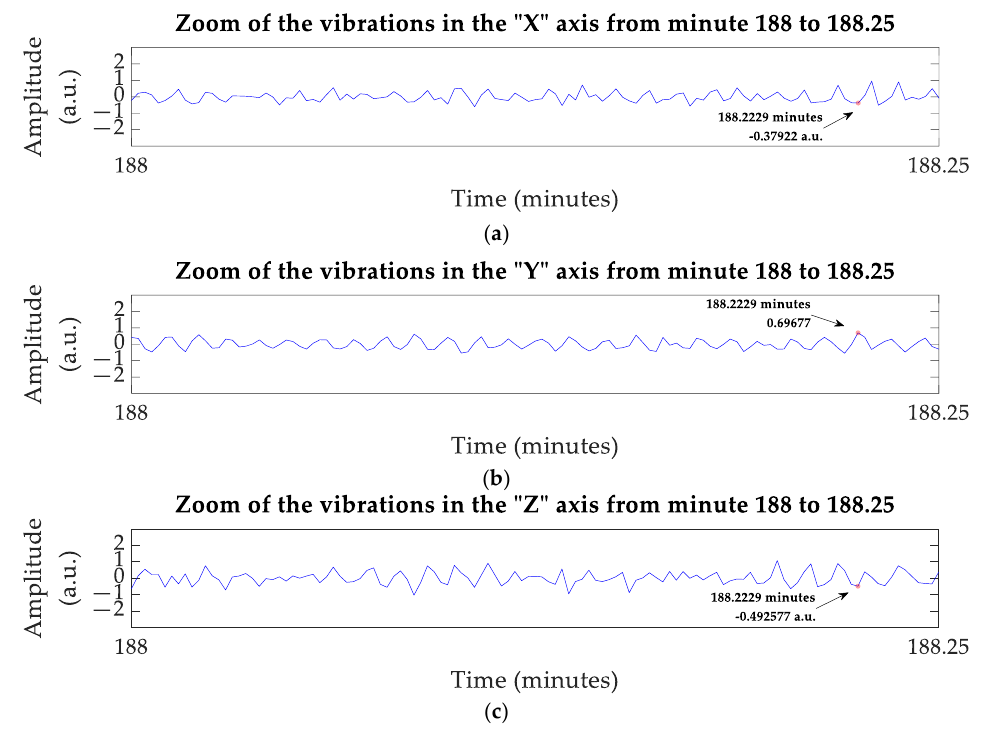
Figure 8. ( a ) Shows a zoom from minute 181.25 to minute 181.5 on the “ X ” axis, a.u (arbitrary units); ( b ) Shows a zoom from minute 181.25 to minute 181.5 on the “ Y ” axis, a.u (arbitrary units); ( c ) Shows a zoom from minute 181.25 to minute 181.5 on the “ Z ” axis, a.u (arbitrary units).